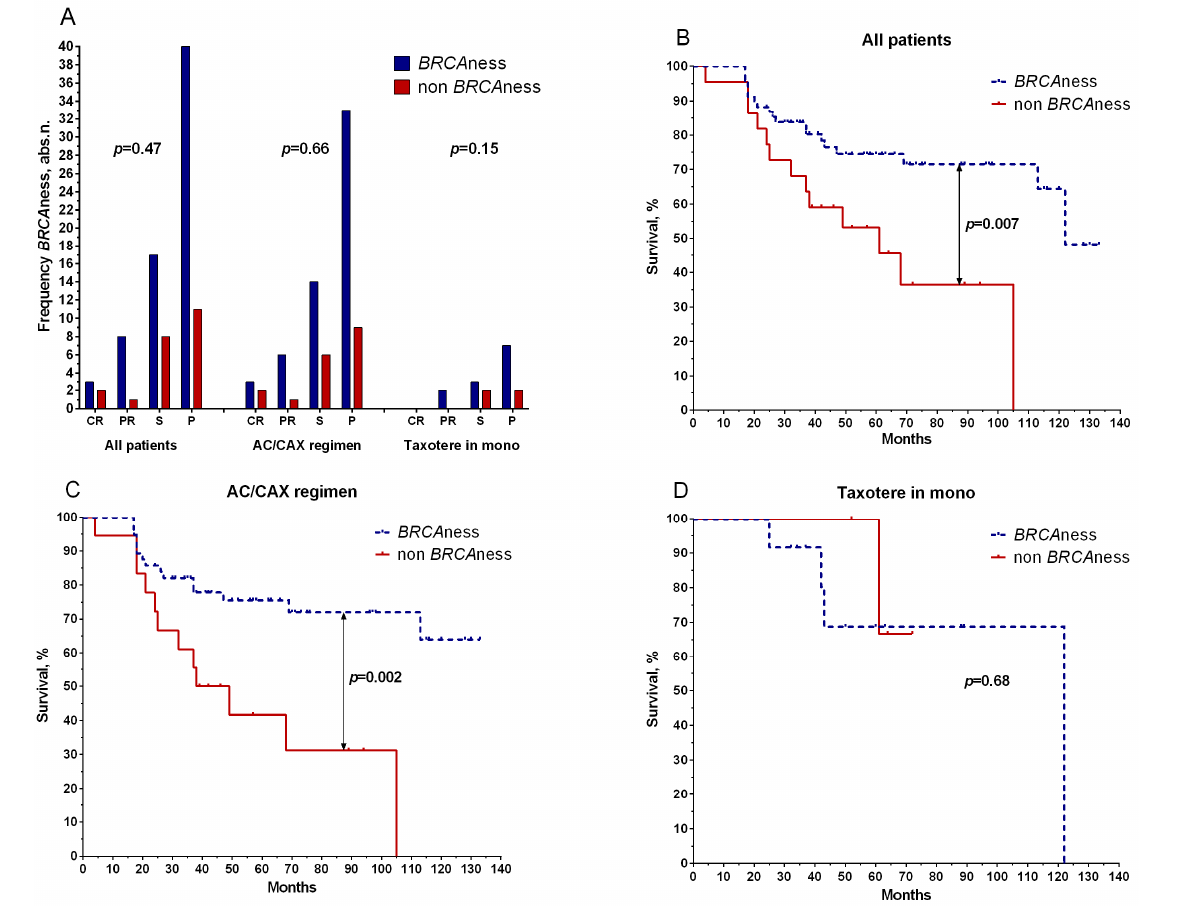
Figure 3. Relationship between BRCAness phenotype with effectiveness of NAC ( A ) and metastatic survival in the general group of patients ( B ), patients treated with anthracycline-containing regimen (AC/CAX) ( C ), and patients treated with taxotere monotherapy ( D ). CR: complete regression; PR: partial regression; ST: stabilization; P: progression. Wilcoxon–Mann–Whitney test was used to test significance of differences among the study groups. Frequency comparisons were based on two-tailed Fisher’s test or chi-squared